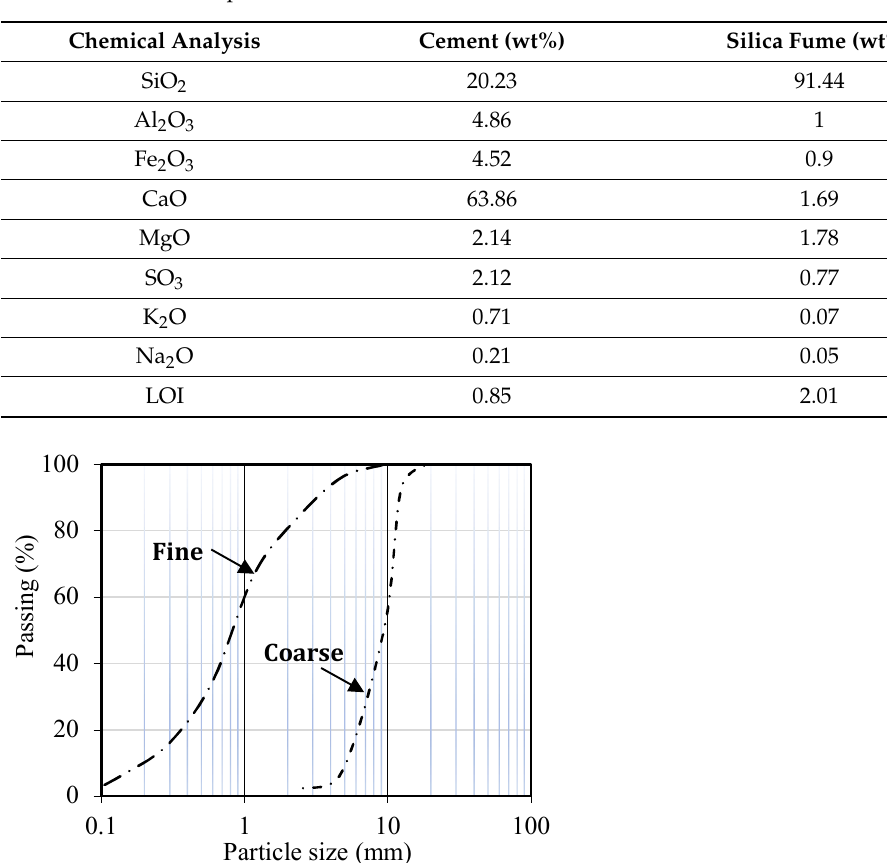
Table 4. Properties of steel fibers.